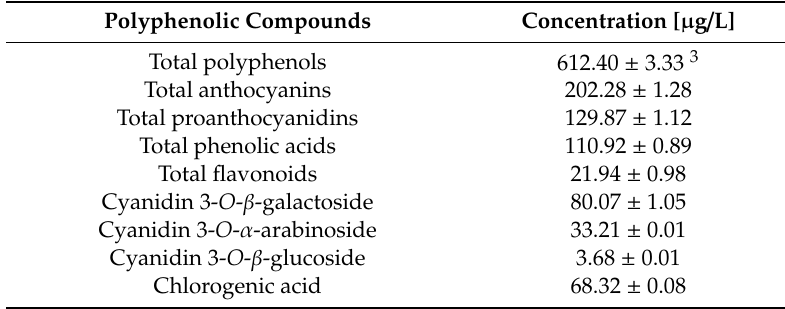
Table 2. The concentrations of polyphenolic compounds in the 0.1% extract from Aronia melanocarpa L. berries (adapted from [11]).